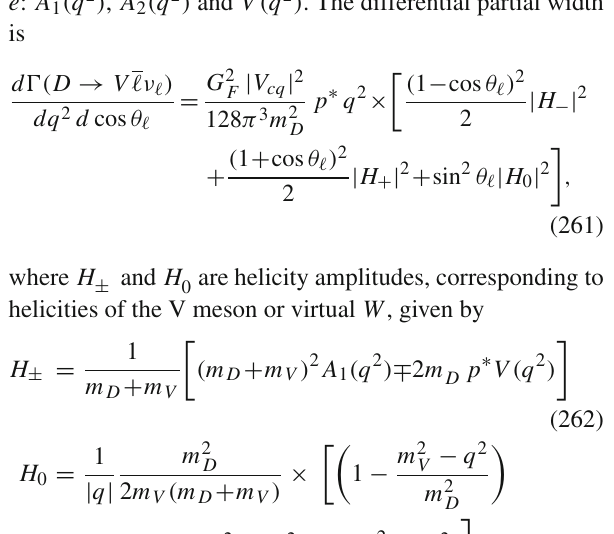
Fig. 202 Decay angles θ V , θ (cid:12) and χ . Note that the angle χ between the decay planes is defined in the D -meson reference frame, whereas the angles θ and θ (cid:12) are defined in the V meson and W reference frames, V respectively